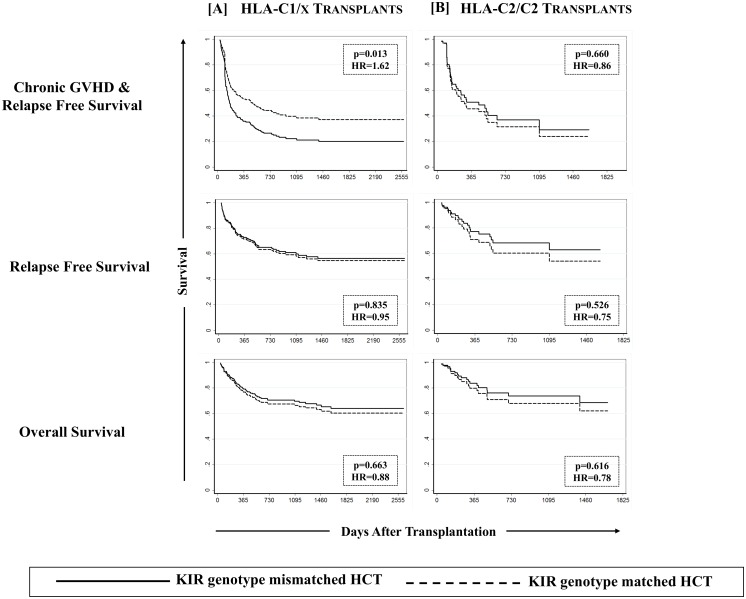
Effect of KIR genotype matching on cGVHD & relapse-free survival (cGRFS) among C1/x recipients.As with cGVHD, KIR genotype matching segregated only the recipients having one or two C1 bearing HLA-C allotypes for differences in cGRFS in a multivariate Cox proportional hazards regression that accounted for covariates for both GVHD and relapse. No effect on relapse free survival (RFS) or overall survival (OS) was noted.